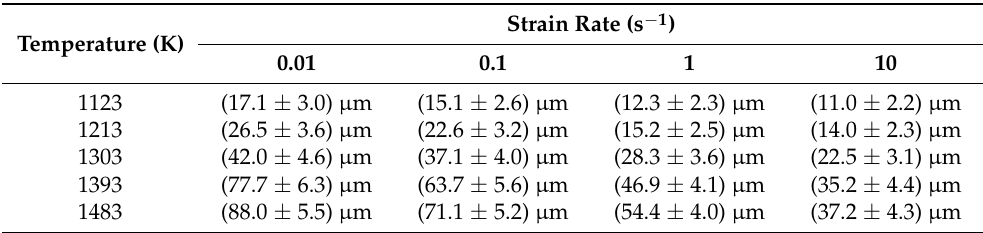
Table 3. Average grain size and corresponding standard deviation of SAE 5137H steel under temper- atures of 1123–1483 K and strain rates of 0.01–10 s − 1 .